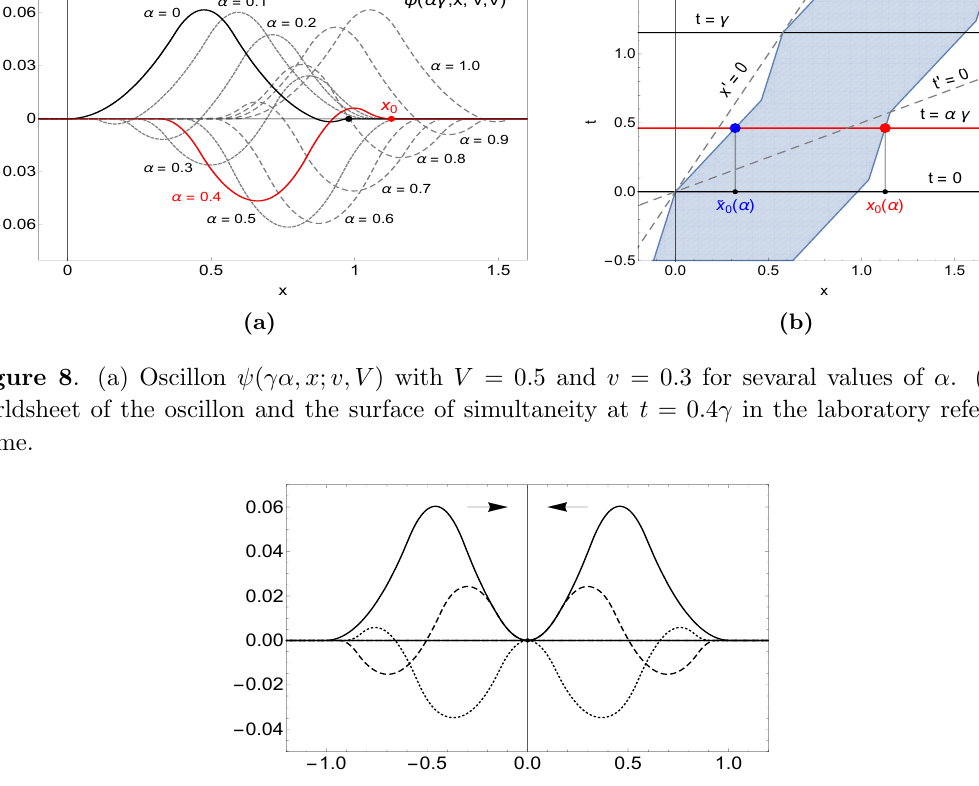
(cid:0) 0 : 1 (cid:25) 0 : 3545. The phases of 2+ v